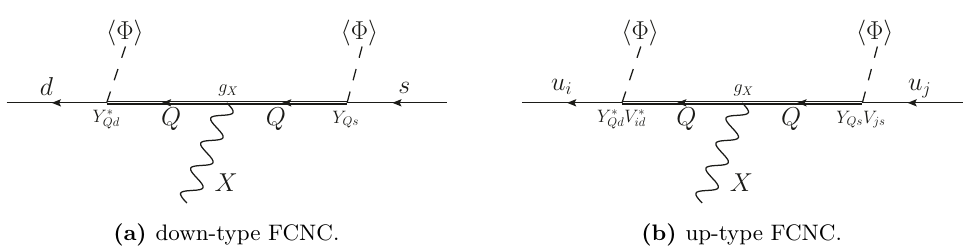
Figure 3. The diagrams which contribute to dsX FCNC process with X gauge boson coupled to a heavy vector-like quark Q (model